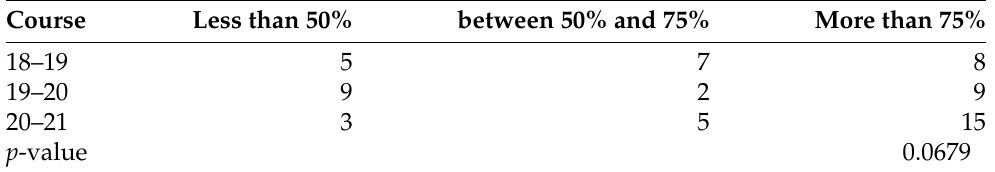
Table 17. Attendance to seminars frequency table and p -value applying Fischer’s exact test Pharmacy.